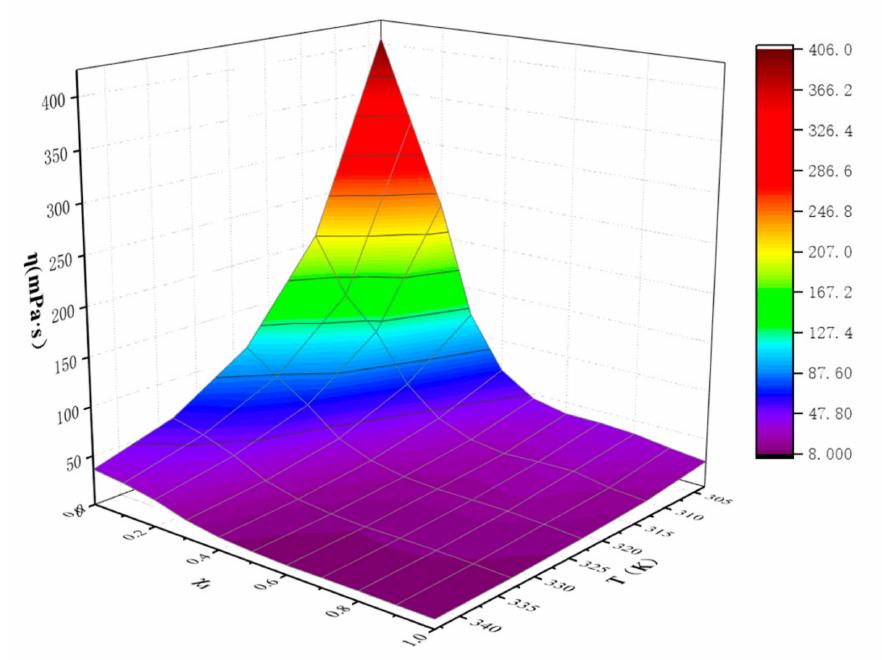
Figure 3. Pseudo-quantitative change of viscosity η with temperature and composition for the ([EMIM] [TFA] + TEA) binary systems. Table 3. The fitting parameters (A i ) and the determination coefficients (R 2 ) of Equation (1) for